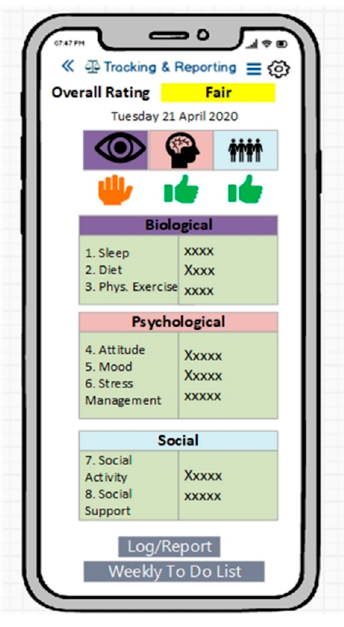
Figure 4 . Prototype of mobile app . Figure 4. Prototype of mobile app.